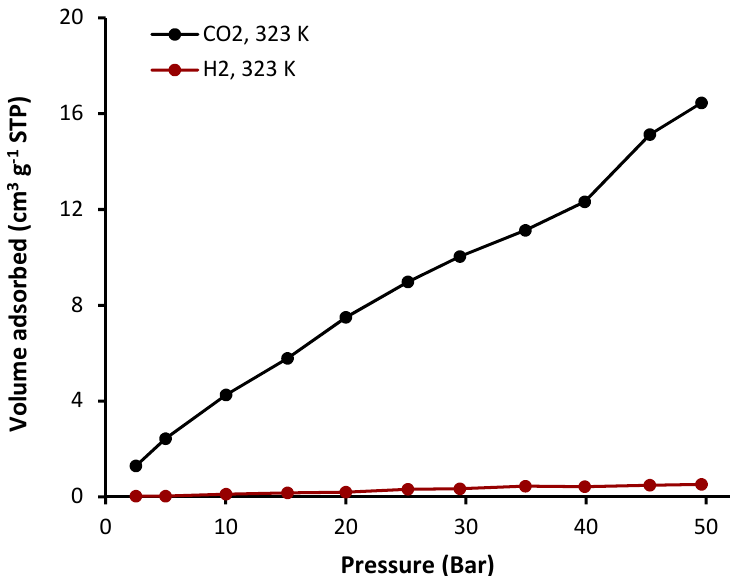
Figure 10. Adsorption isotherms of CO 2 and H 2 for complex 3 .